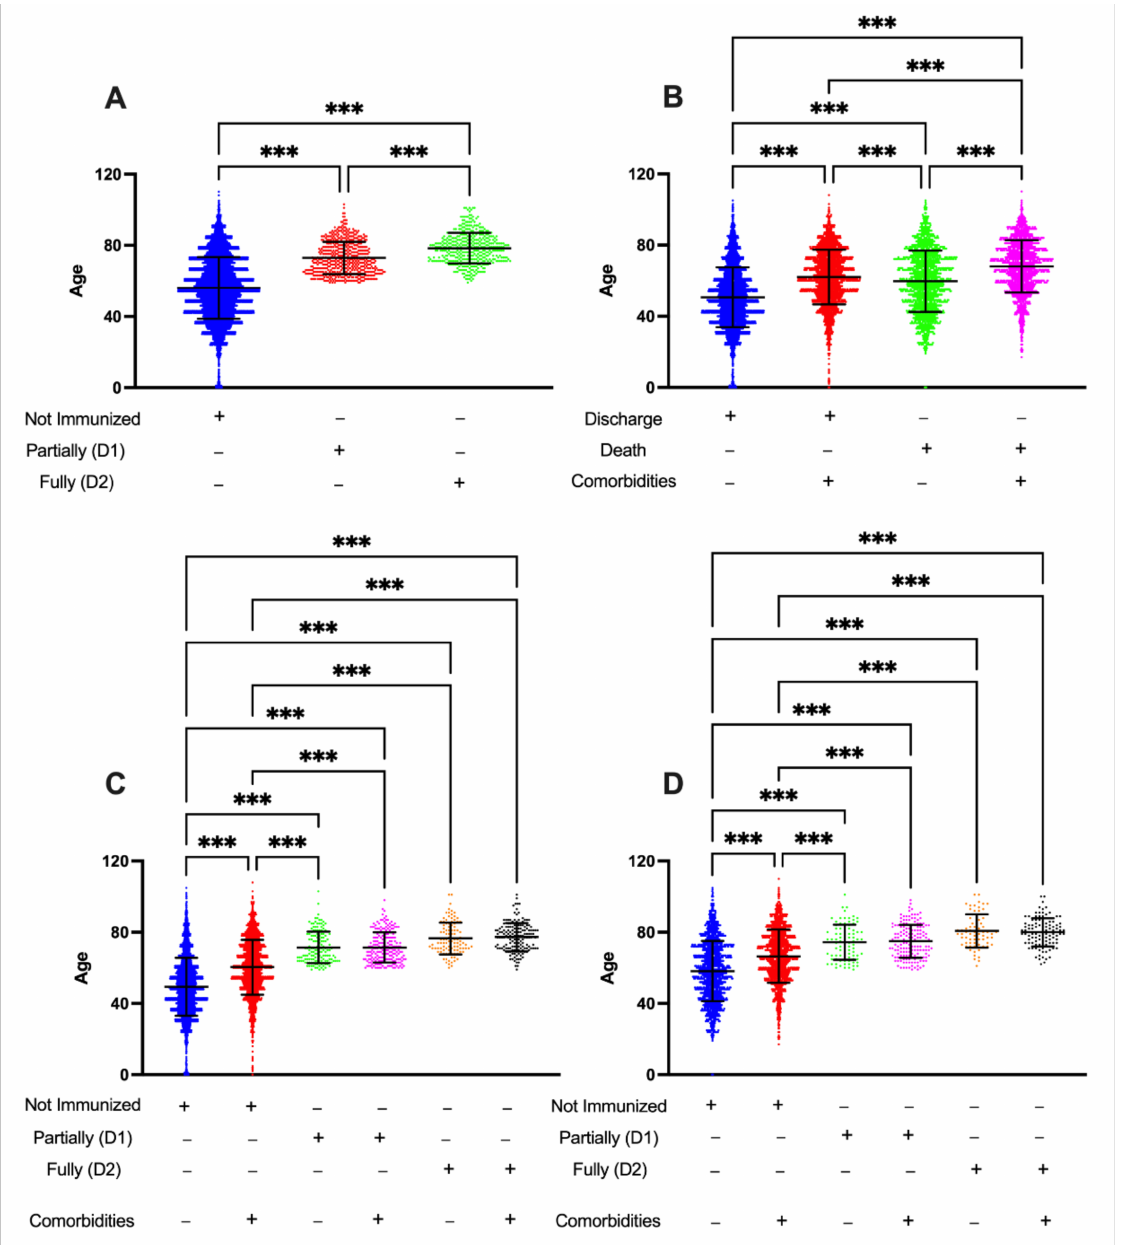
Figure 1. General overview of all analyzed patients according to their age, comorbidities, outcomes, and immunization status. Considering the hospitalizations of moderate and severe COVID-19 cases between April 2020 and August 2021, we analyzed data from 23,516 patients and excluded those hospitalized through direct occupancy, with unknown outcomes, or patients with an unconfirmed COVID-19 case. Based on these criteria, data from 12,635 hospitalized patients were analyzed and cross-referenced with vaccination data. ( A ) Age of hospitalized patients according to their immunization status; ( B ) Age distribution of hospitalized patients according to their outcome and comorbidities; ( C ) Age distribution of discharged patients considering their immunization status and existence of comorbidities; ( D ) Age distribution of lethal cases considering their immunization status and existence of comorbidities. The statistical analysis was performed using the Kruskal–Wallis test for group comparison and Dunn’s test to perform multiple comparisons. The results are shown as the mean ± standard deviation (*** p <